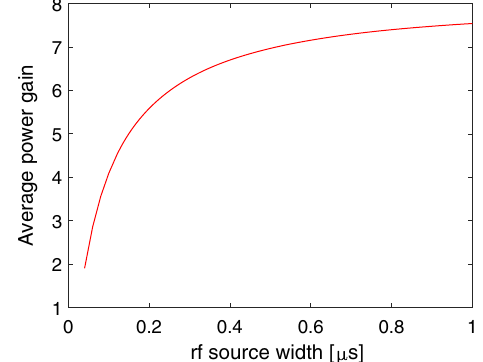
FIG. 7. Accumulated phase advance error given by manufac- turing tolerances for a 30-cm Ka-band structure with a 2-mm iris aperture radius as a function of the designed cell-to-cell phase advance.